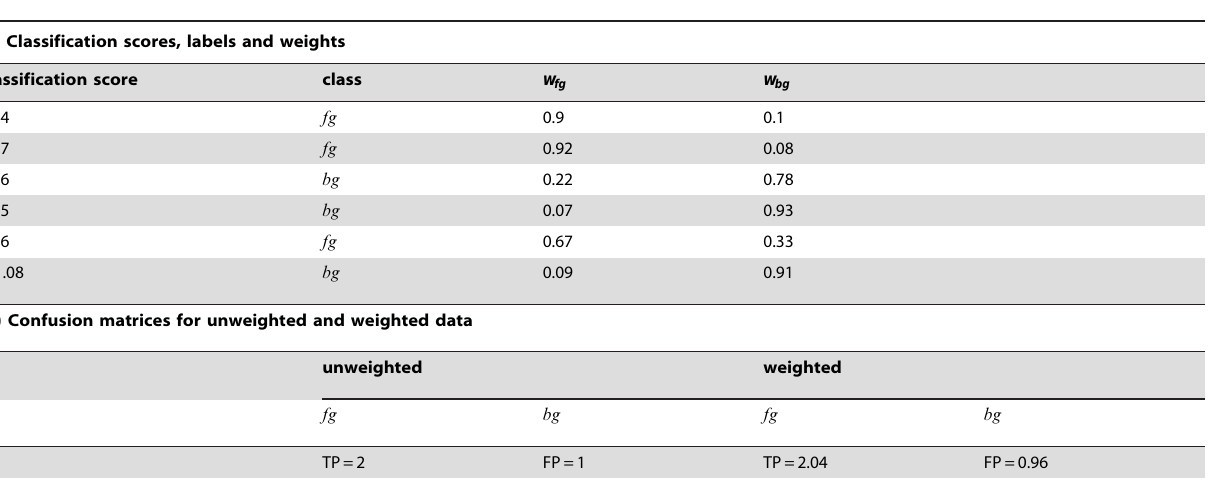
Table 2. Classification for unweighted and weighted